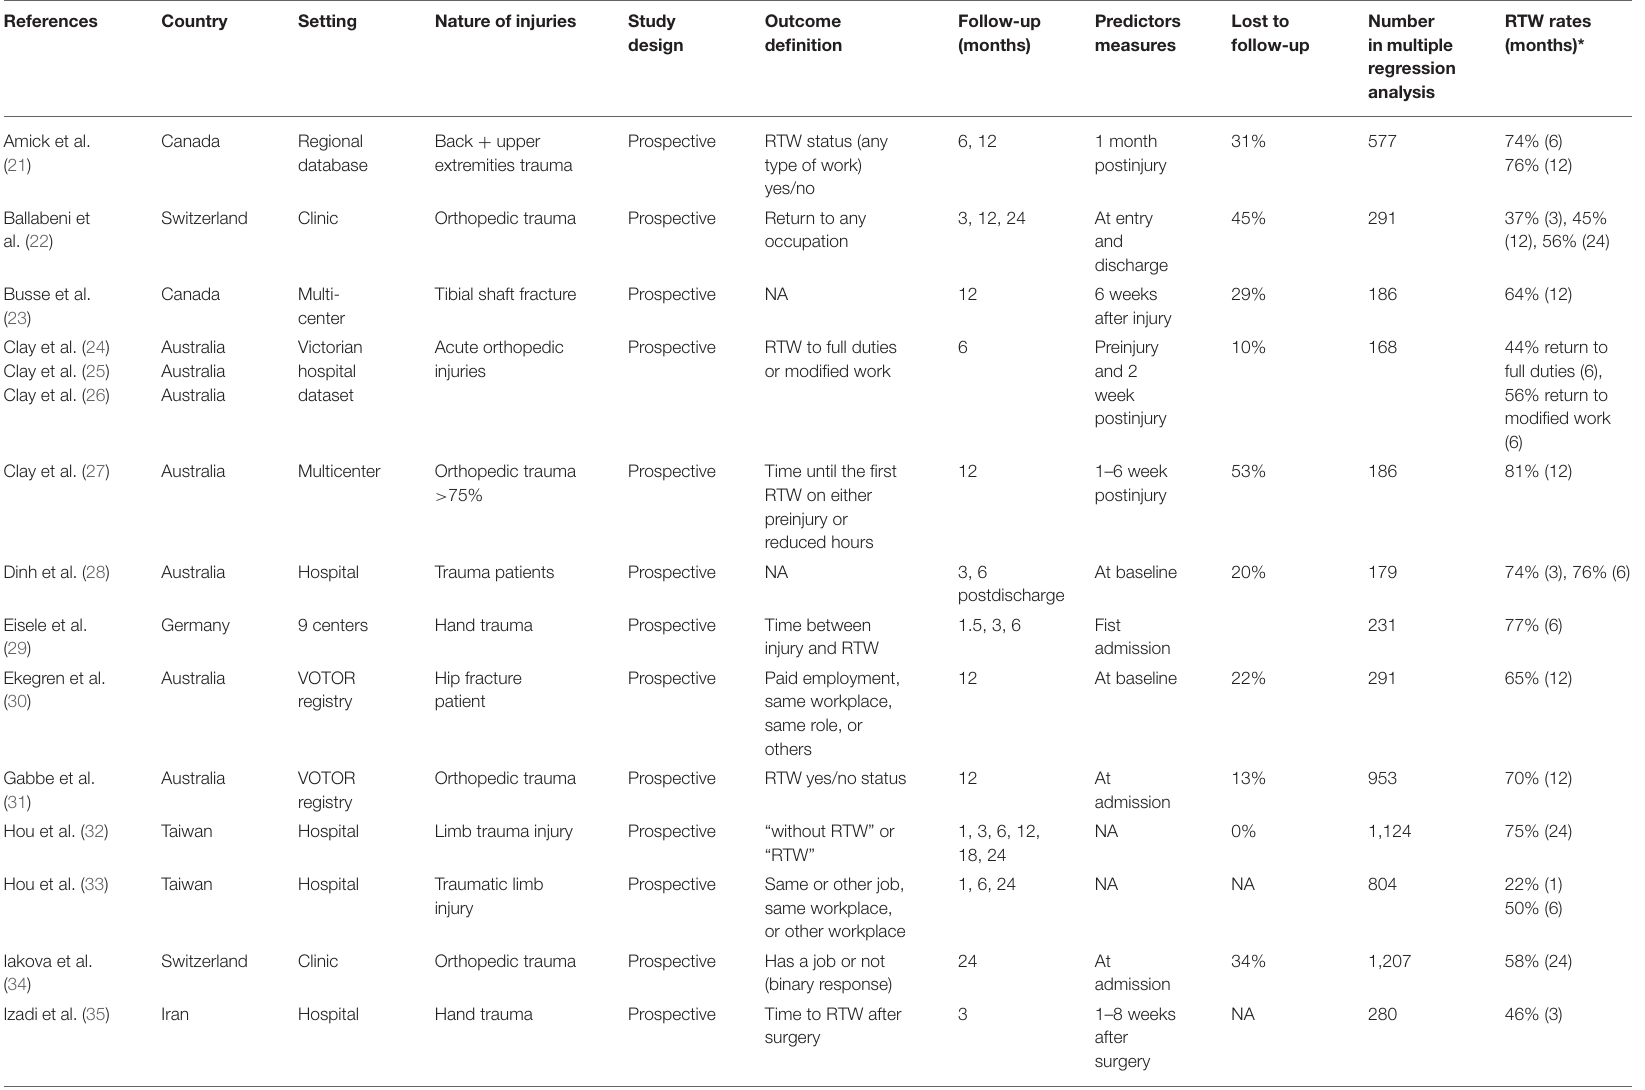
TABLE 1 | Characteristics of included studies ( n =